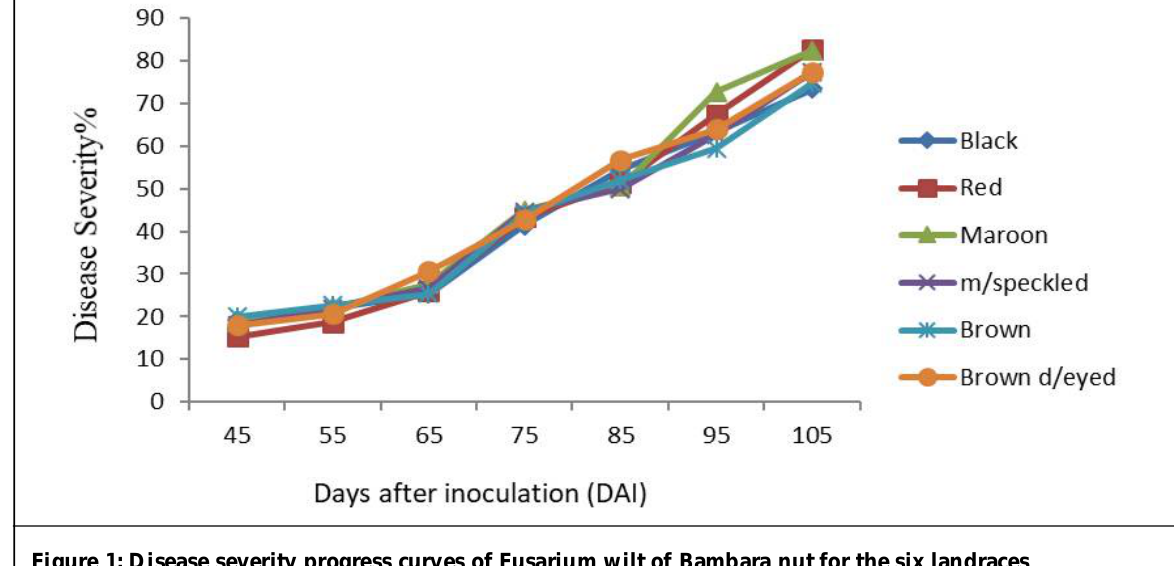
Figure 1: Disease severity progress curves of Fusarium wilt of Bambara nut for the six landraces